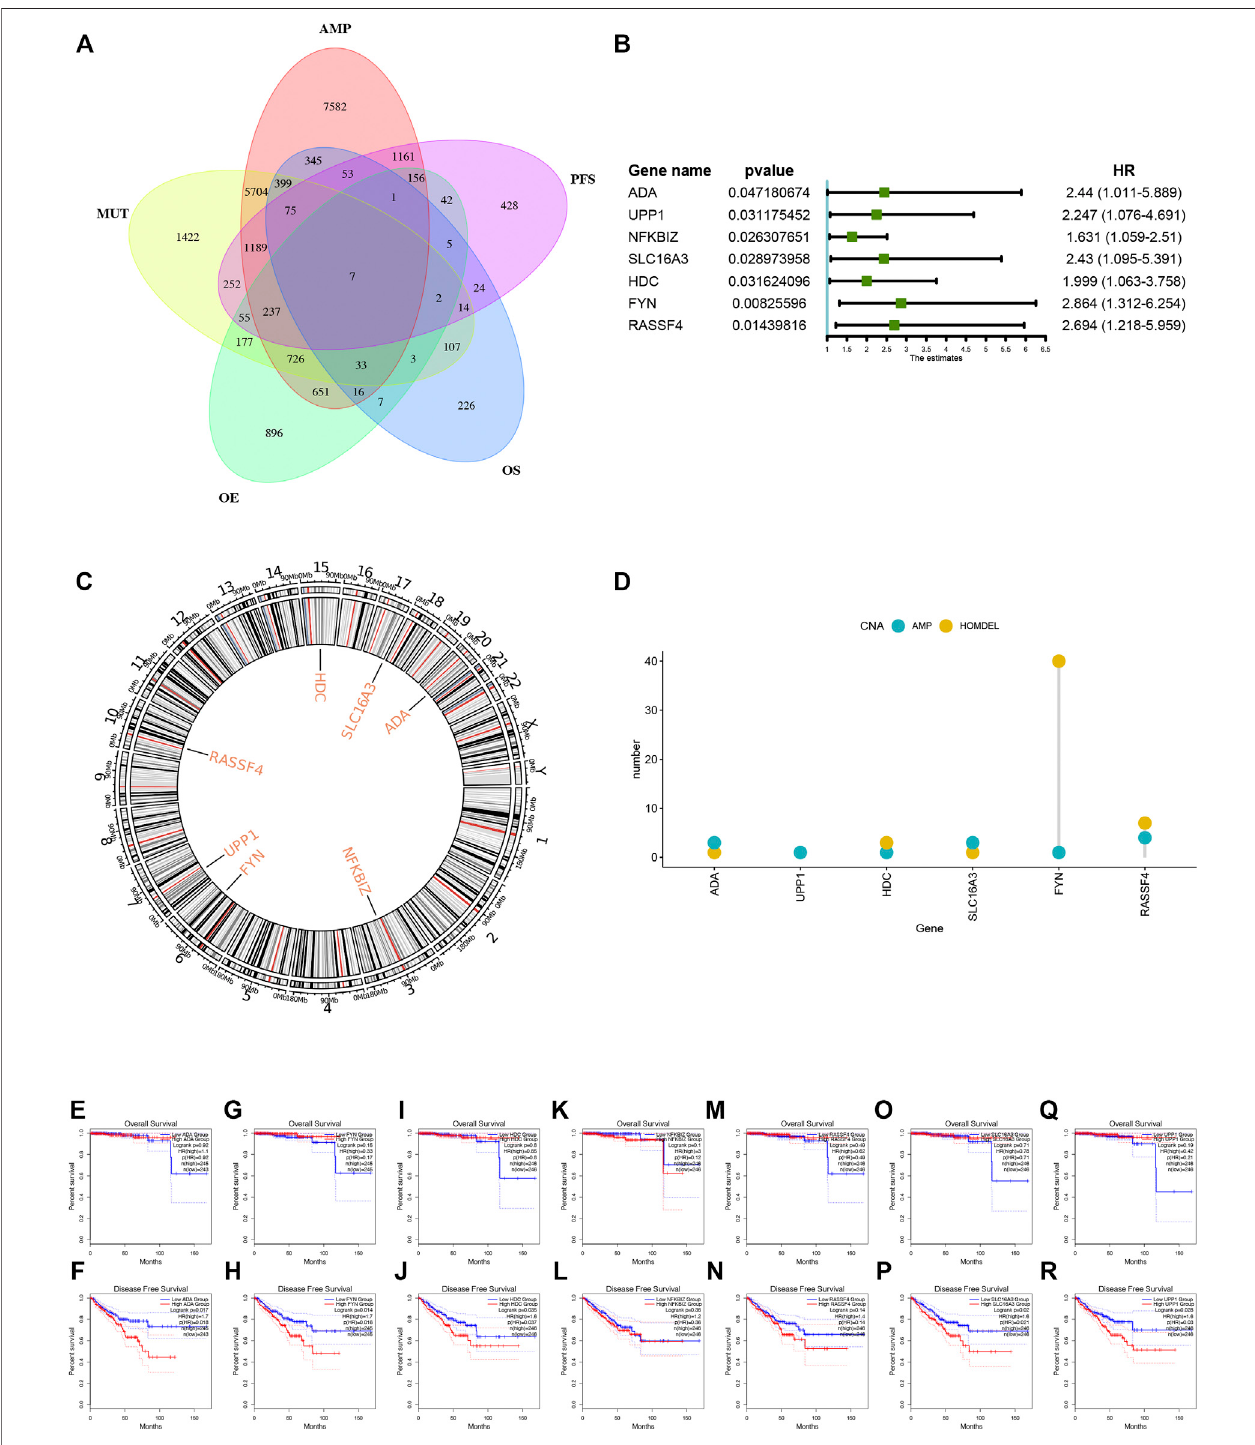
FIGURE 2 | Identi fi cation of tumor antigens associated with PRAD prognosis. (A) Venn diagram identifying the potential tumor antigens with both ampli fi ed and mutated features, and signi fi cant OS and PFS prognosis (in a total of 7 candidates) in PRAD. (B) Forest maps of single factor survival analysis of 7 genes of PAAD. (C) Circos plots of 7 genes revealing the position of chromosomes. (D) The ampli fi ed and Homdel state of 7 candidate genes. (E – R) Kaplan-Meier OS and PFS curves comparing the groups with different expression of ADA (E – F ), FYN (G,H) , HDC (I,J) , NFKBIZ (K,L) , RASSF4 (M,N) , SLC16A3 (O,P) and UPP1 (Q,R) in PRAD.